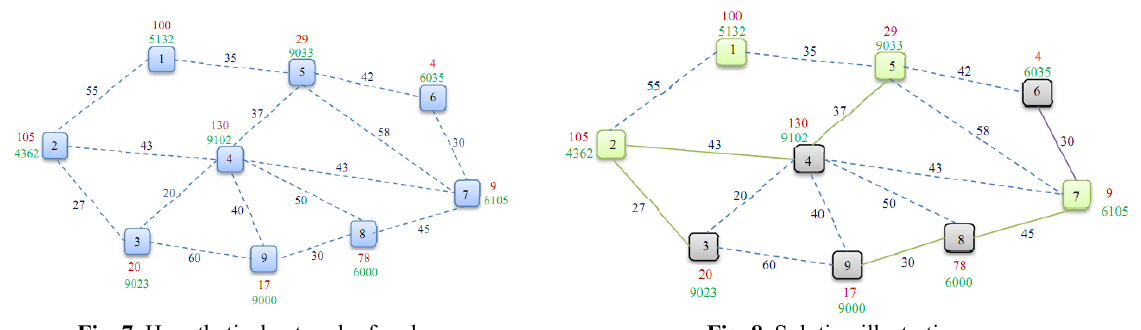
Fig. 7. Hypothetical network of nodes Fig. 8. Solution